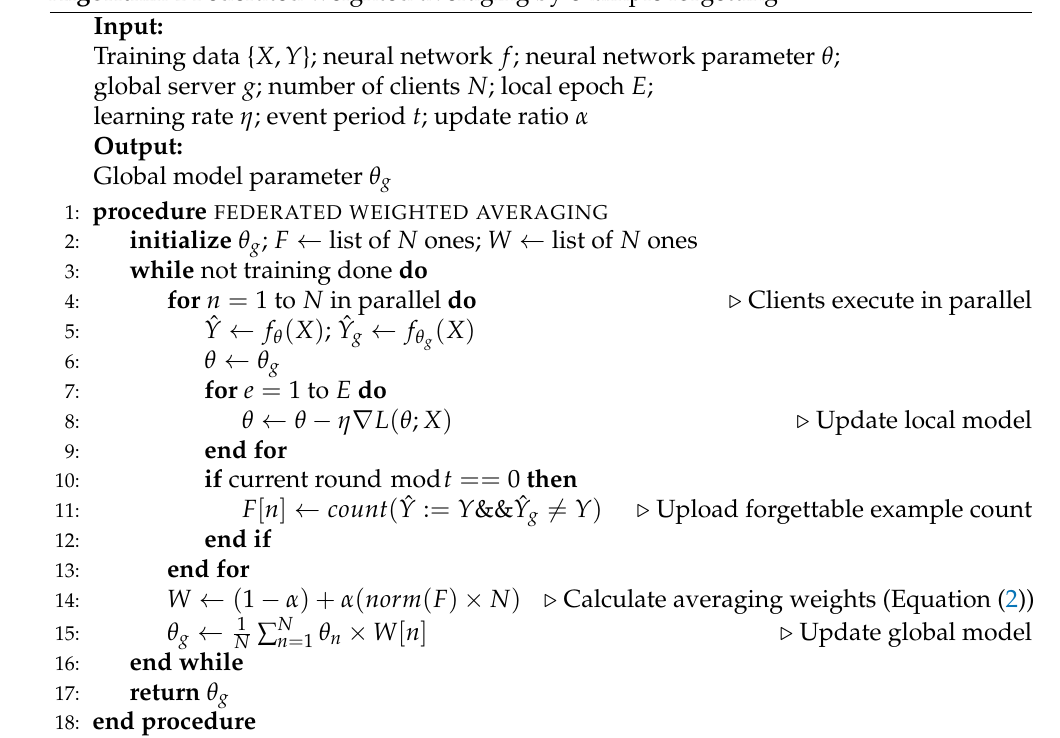
Algorithm 1 Federated weighted averaging by example